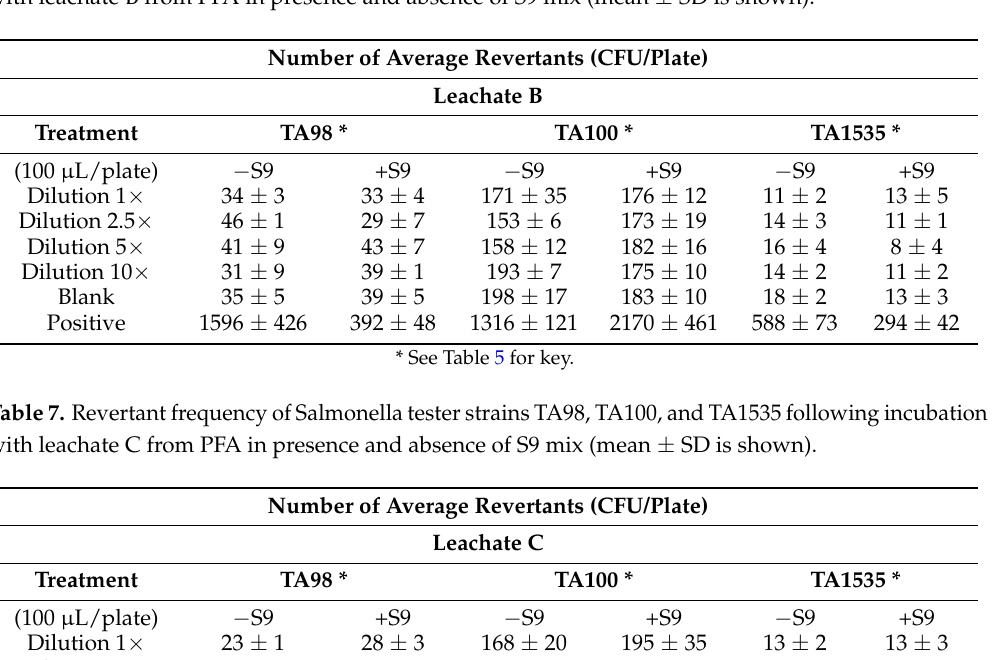
Table 6. Revertant frequency of Salmonella tester strains TA98, TA100, and TA1535 following incubation with leachate B from PFA in presence and absence of S9 mix (mean ± SD is shown).